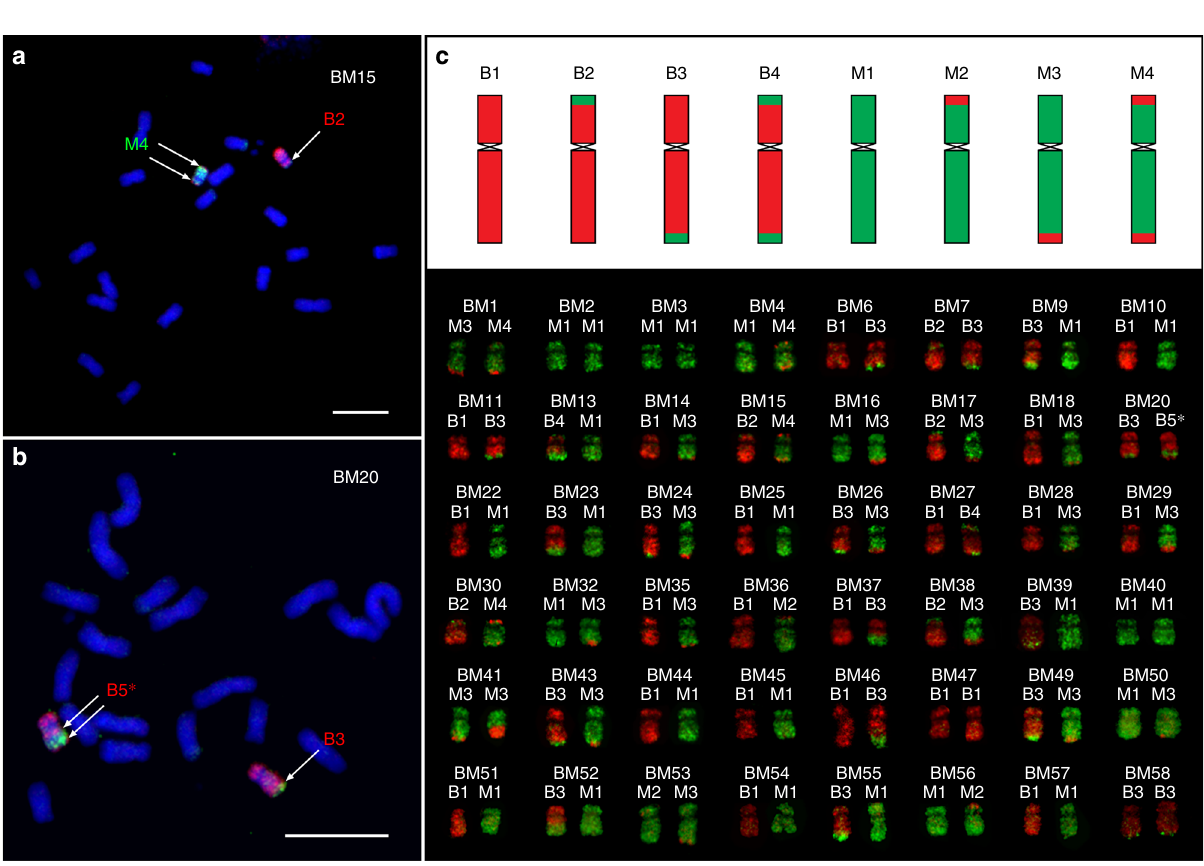
Fig. 3 Crossovers between B73 and Mo17 chromosome 10 revealed by oligo-FISH mapping using probes hapB and hapM. a Oligo-FISH mapping of B73 × Mo17 F 2 plant BM15. Probes hapB and hapM are shown in red and green, respectively. The single arrow identi fi es a single chromosomal exchange position (EP) on the B2-classi fi ed chromosome. Double arrows point to the two chromosomal EPs on the M4-classi fi ed chromosome. Bar = 10 μ m. b Oligo-FISH mapping of B73 × Mo17 F 2 plant BM20. The single arrow points a single EP on the B3-classi fi ed chromosome. Double arrows point to the two EPs of double crossovers (COs) on the B5 ∗ -classi fi ed chromosome. Bar = 10 μ m. c Upper panel: diagrams of the 8 types of parental or recombinant chromosomes identi fi ed in F 2 plants. B indicates B73; M indicates Mo17. Lower panel, representative images of the two copies of chromosomes 10 in 48 F 2 plants.